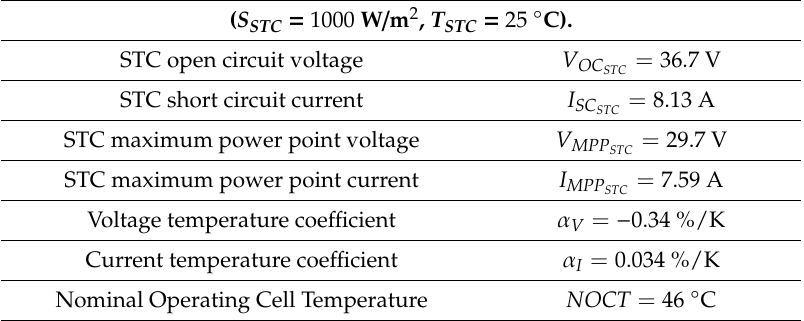
Table 1. SolarWorld SW 225 PV module electrical characteristics in standard test conditions (STC).